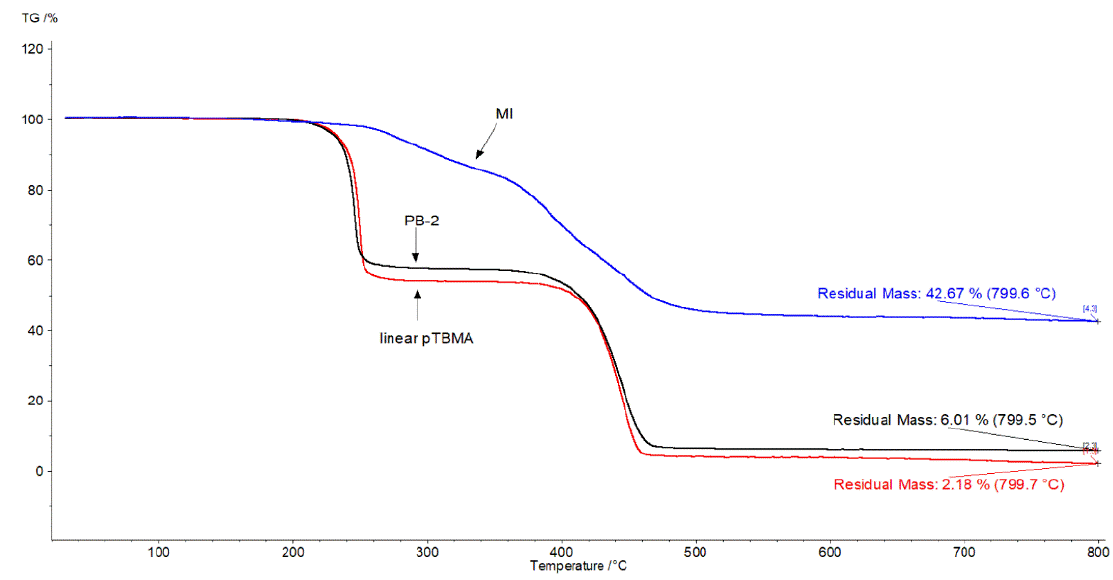
Figure 7. Thermogravimetric analysis data of MI, PB2 and linear PtBMA.